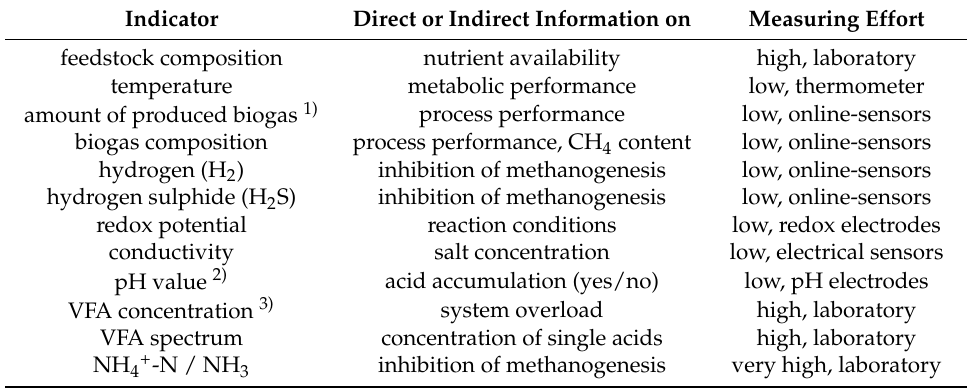
Table 1. Overview on indicators commonly used to monitor process stability and efficiency (compiled from [27–29]). Given are the indicators, the direct or indirect information on the process as well as efforts which are required for their measurements. CH 4 = methane, VFA = volatile fatty acids, NH 4+ = ammonium, NH 3 =